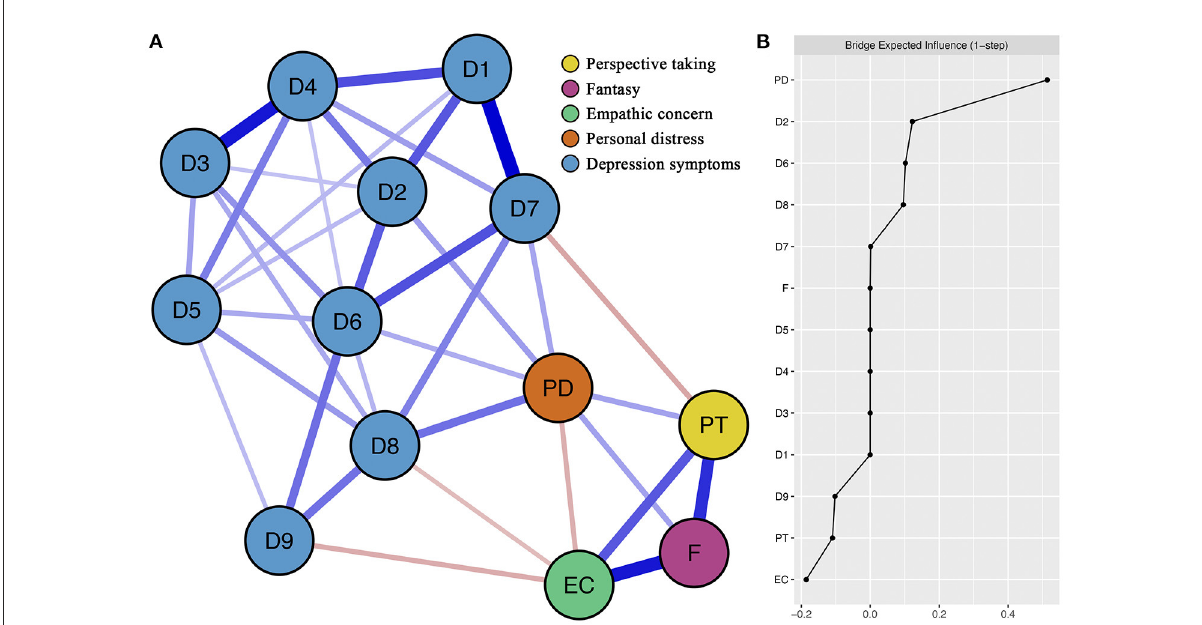
FIGURE1 Network structure of different dimensions of empathy and different symptoms of depression. (A) Blue edges represent positive correlations, and red edges represent negative correlations. The thickness of the edge reflects the magnitude of the correlation. The text of variables selected in the network can be seen in Table 2. (B) Centrality plot depicting the bridge expected influence of each variable in the